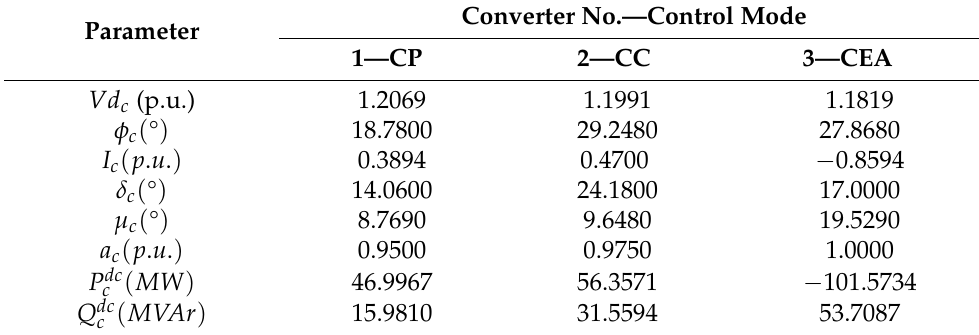
Table 13. HVDC system result for Case